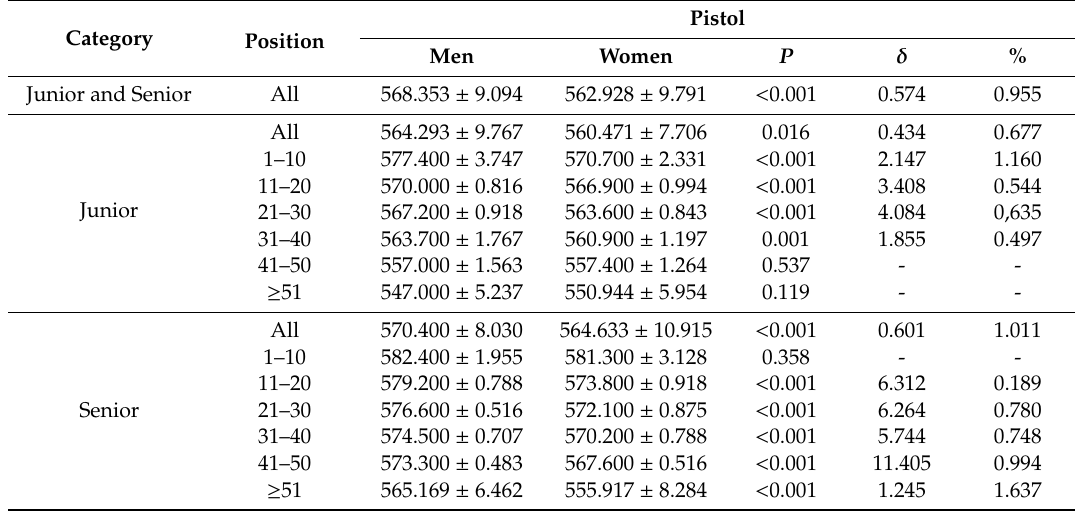
Table 2. Performance contrast between men and women in pistol